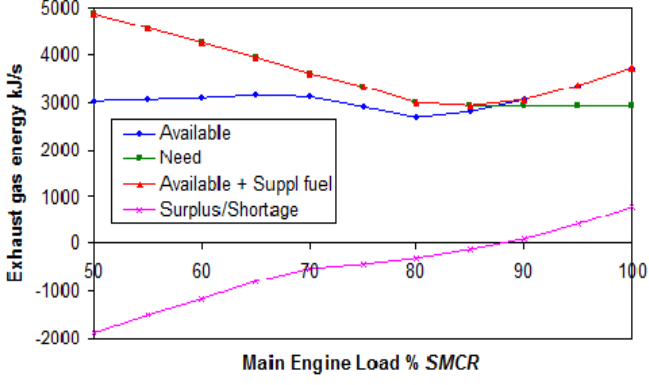
Figure 9. Exhaust gas energy and supplemental HFO at full electrical power for the R245fa fluid.